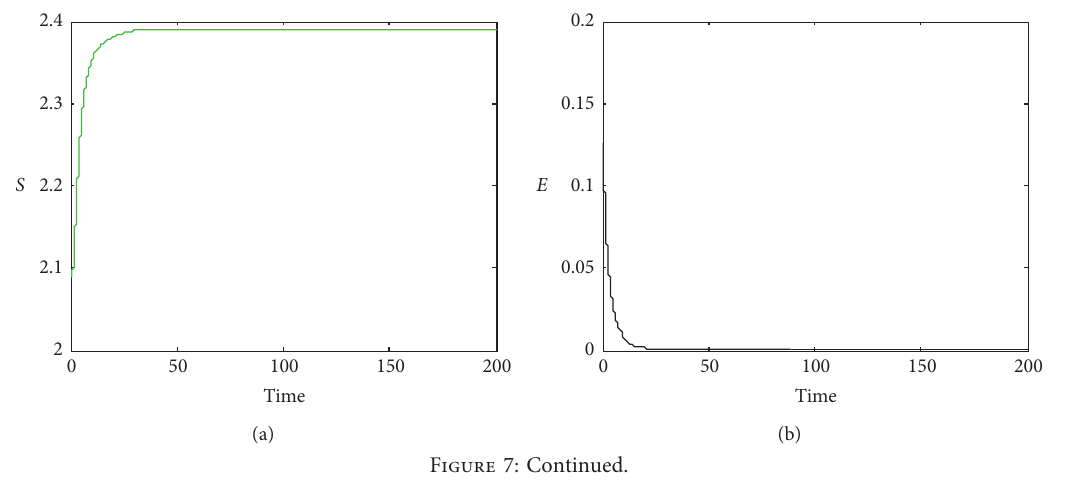
Figure 6: Bifurcation diagram.